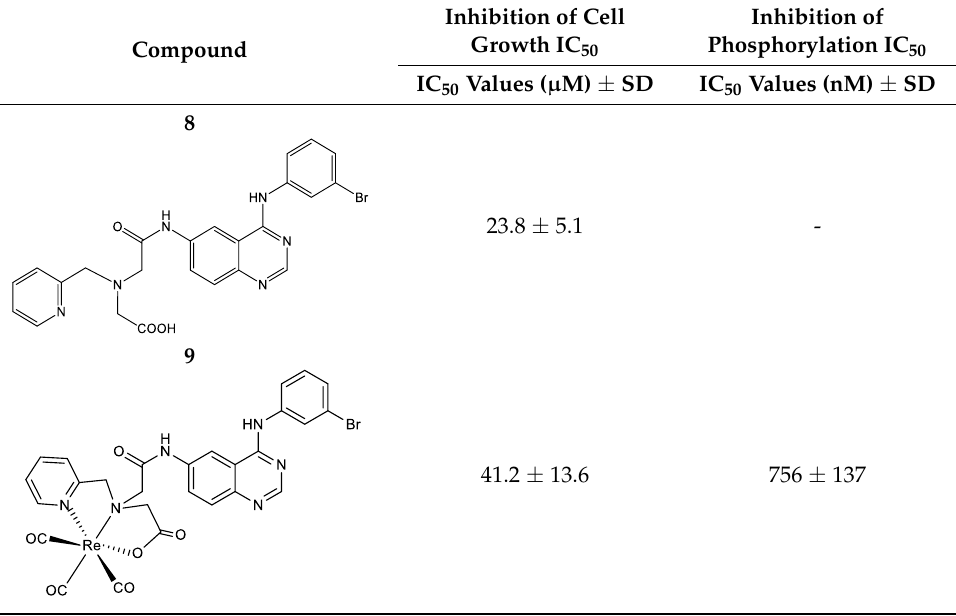
Figure 2. Dose − response curves from MTT assay for the ligands 4 , 6 , and complexes 5a , 7a at a concentration range from 1 mM to 10 nM. Table 3. Inhibition of EGFR phosphorylation and inhibition of A431 cell growth of quinazoline derivatives present in the literature [10,11,13].